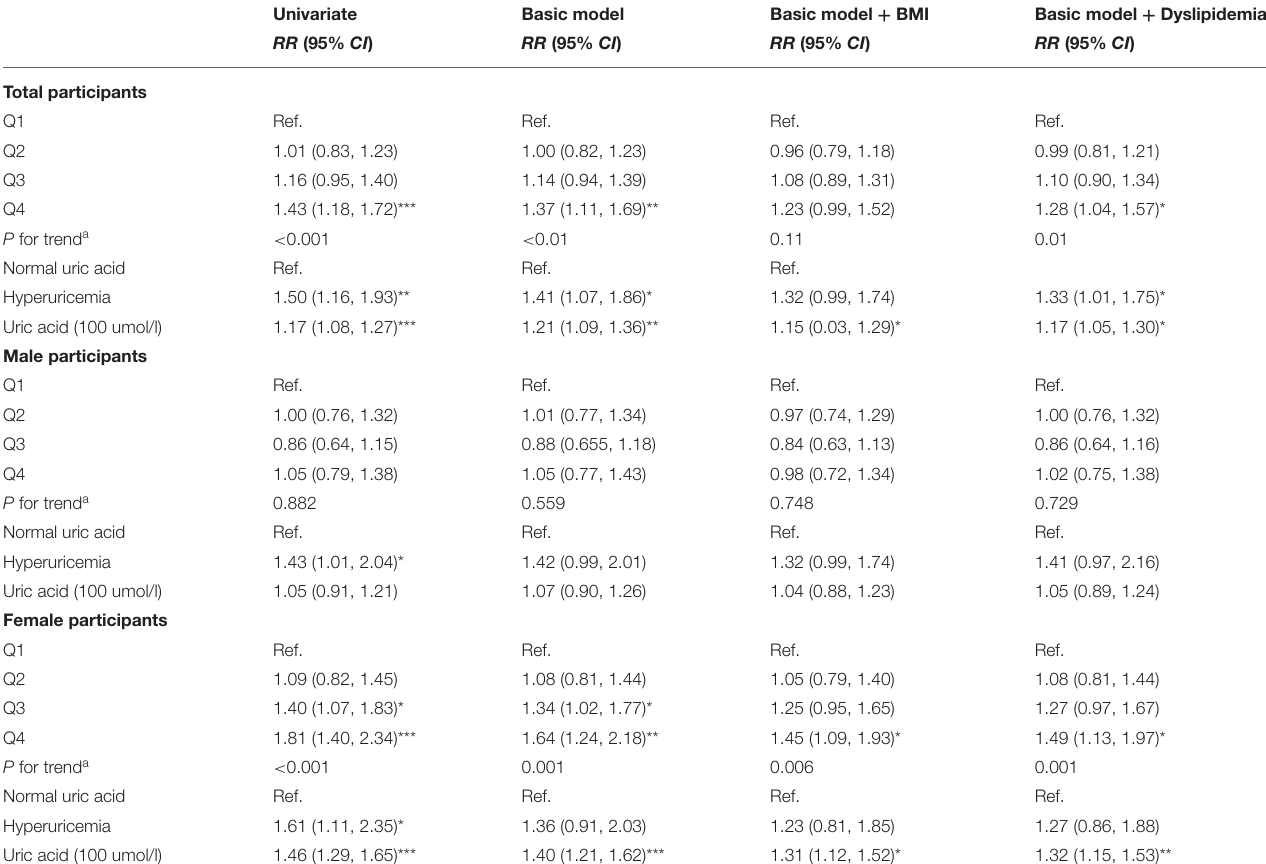
TABLE 2 | Risk ratios (95% confidence intervals) of diabetes according to